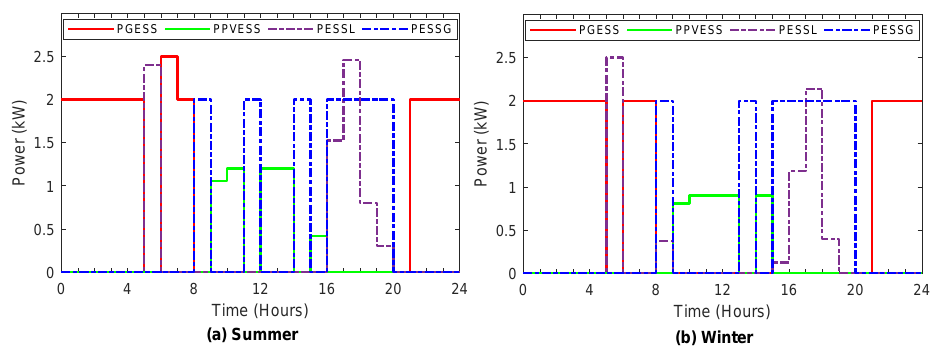
Figure 7. Optimal power flows from/to energy storage system during summer and winter. The optimal power flows from/to EV battery during the typical day in winter and summer are plotted in Figure 8. The electric vehicle power flows include charging EV from the grid during the off-peak periods, charging EV from solar when the solar generation is higher than the load demand, and EV discharging to feed the load. In addition, this involves meeting the load demand through discharging of EV to feed the load demand when the load demand is greater than the generated PV and has not been fed by the ESS, after making sure that the energy stored in the EV battery is more than the amount of energy required for the remaining electric vehicle